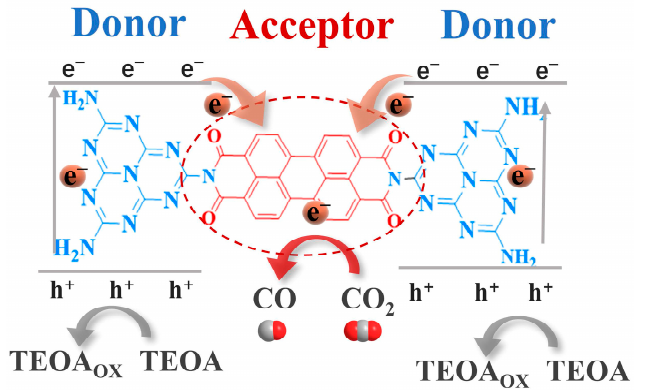
Figure 8. The mechanism of g-CN-1 mg PTCDA as a photocatalyst for CO 2 reduction is proposed.